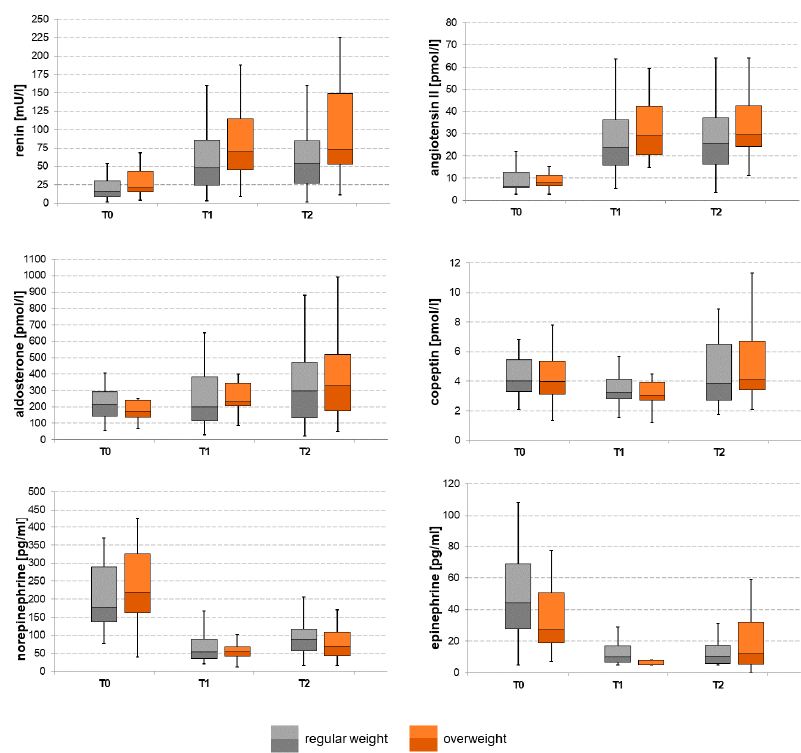
Figure 4. Hormone levels of renin, angiotensin II, aldosterone, copeptin, norepinephrine and epinephrine during the course of anesthesia comparing the two groups “regular weight” and “overweight” represented in boxplots. The hormone levels were measured at three di ff erent time points: preoperative (T0), 15 min (T1) and 45 min after the induction of anesthesia (T2). In the comparison of the groups, there was only a di ff erence in epinephrine at timepoint T2, whereby the level in the overweight patients decreased to be significantly less in absolute terms compared to the initial value ( p =